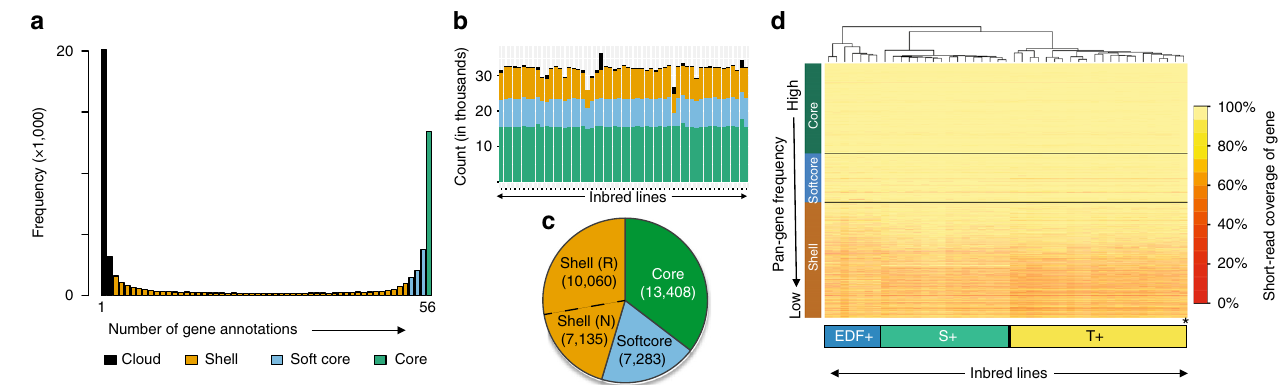
Fig. 2 Gene-based pan-genome. Annotated genes (genomic sequence) from all genomes were clustered, and a single representative from each cluster was selected to create a gene-based pan-genome. a Number of pan-gene clusters represented within respective numbers of inbred line annotations. b Number of core, softcore, shell, and cloud pan-genes for individual inbred lines. c Number of core, softcore, and shell pan-genes in the high-con fi dence pan-genome. Shell pan-genes are divided into reference (R) and non-reference (N). d Percent coverage of 37,886 high-con fi dence pan-genes by short read data sets from 49 lines. Color-coded bars on the lower axis indicate the population groups described in Fig. 4; pan-genome categories are labeled on the vertical axis. Note that short read coverage supports the classi fi cation of the pan-genome compartments and that the clustering of lines by short read coverage matches the population groups identi fi ed in Fig.